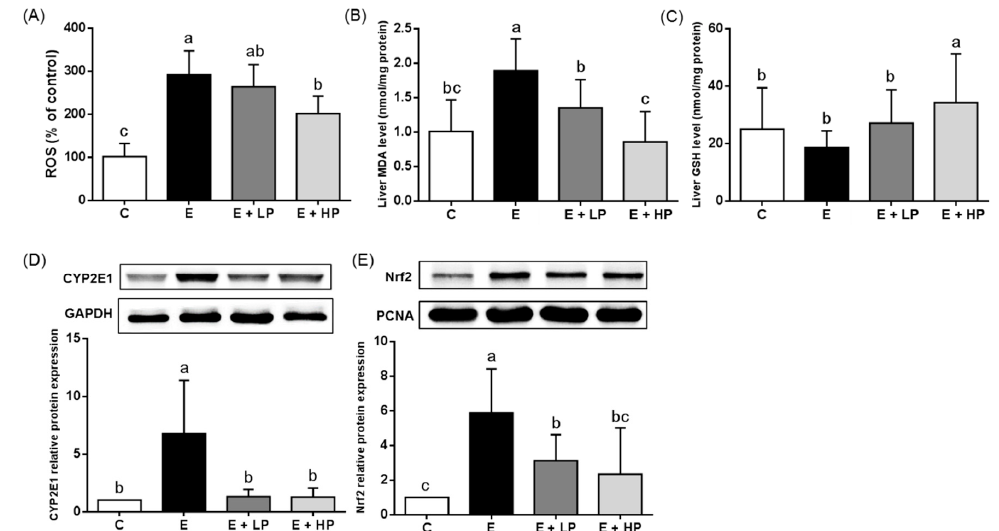
Figure 3. Hepatic ( A ) relative ROS level, ( B ) MDA and ( C ) GSH concentrations, and ( D ) CYP2E1 and